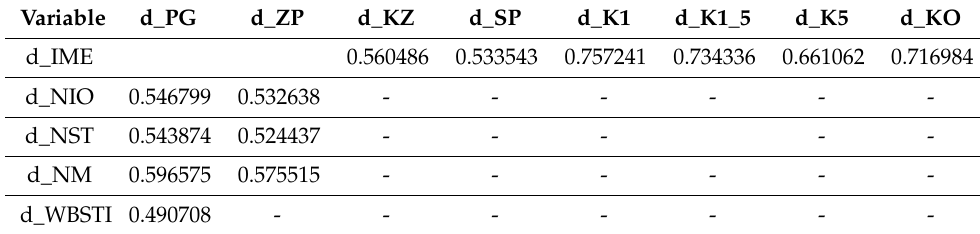
Table 2. Significant correlation coefficients between the